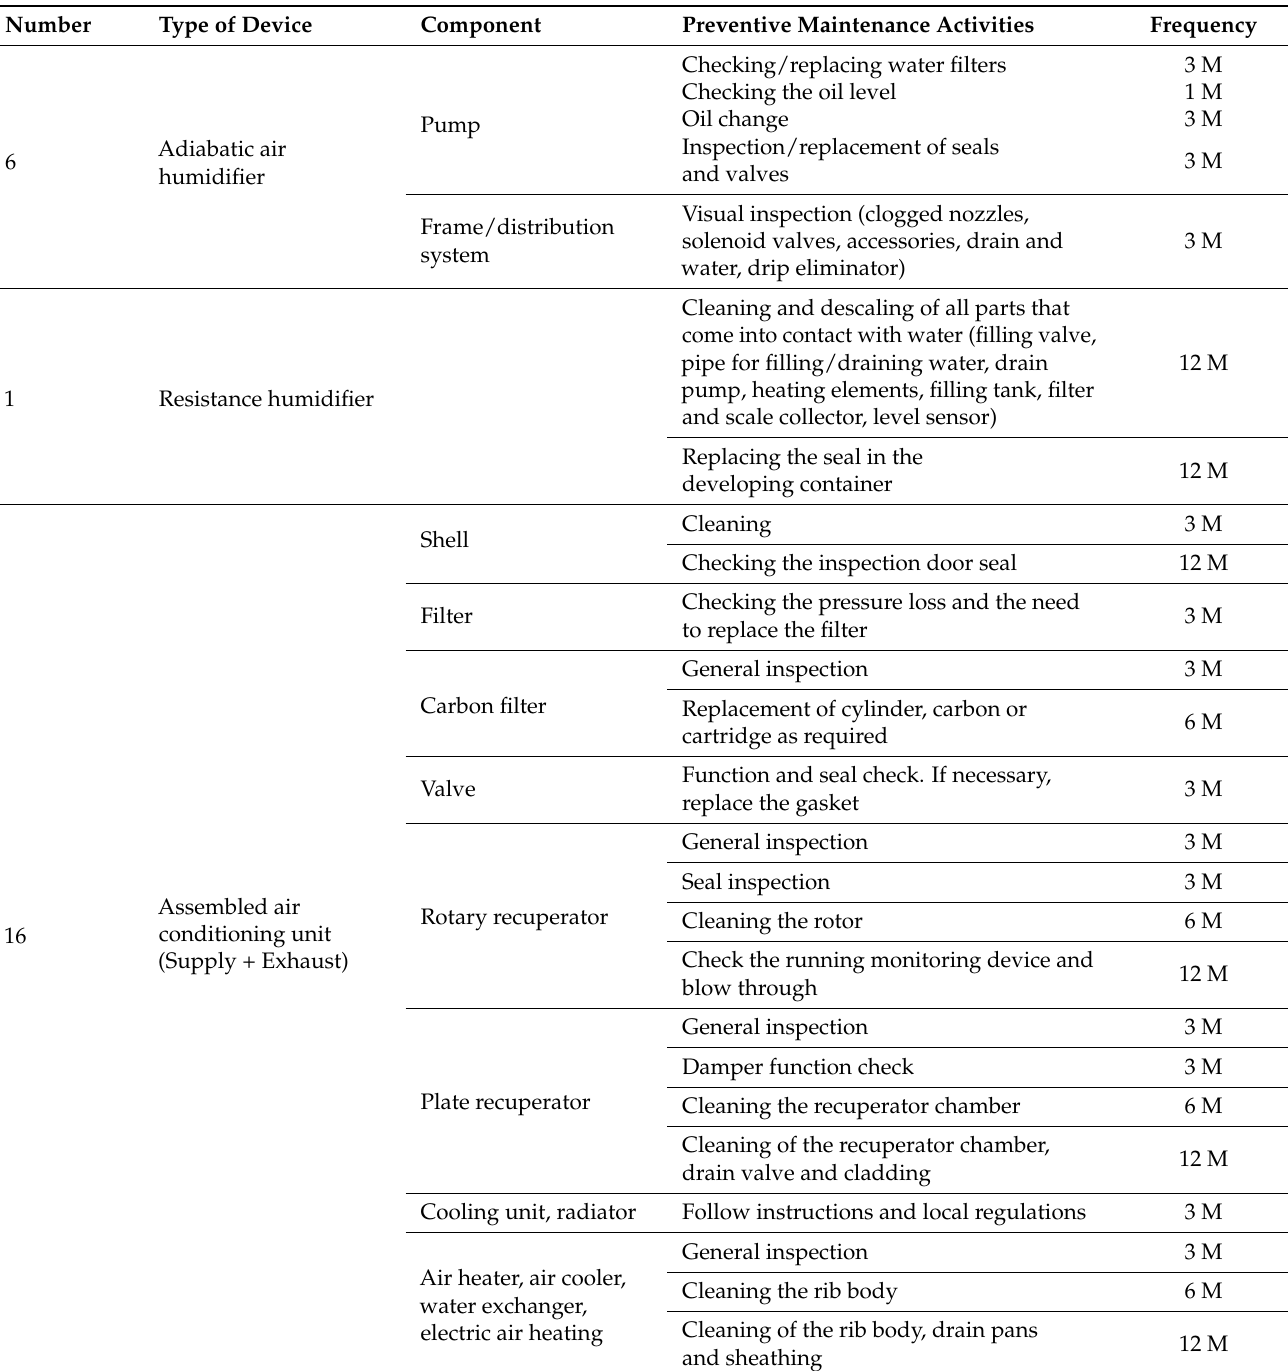
Table 1. Preventive maintenance requirements for selected equipment. Source: